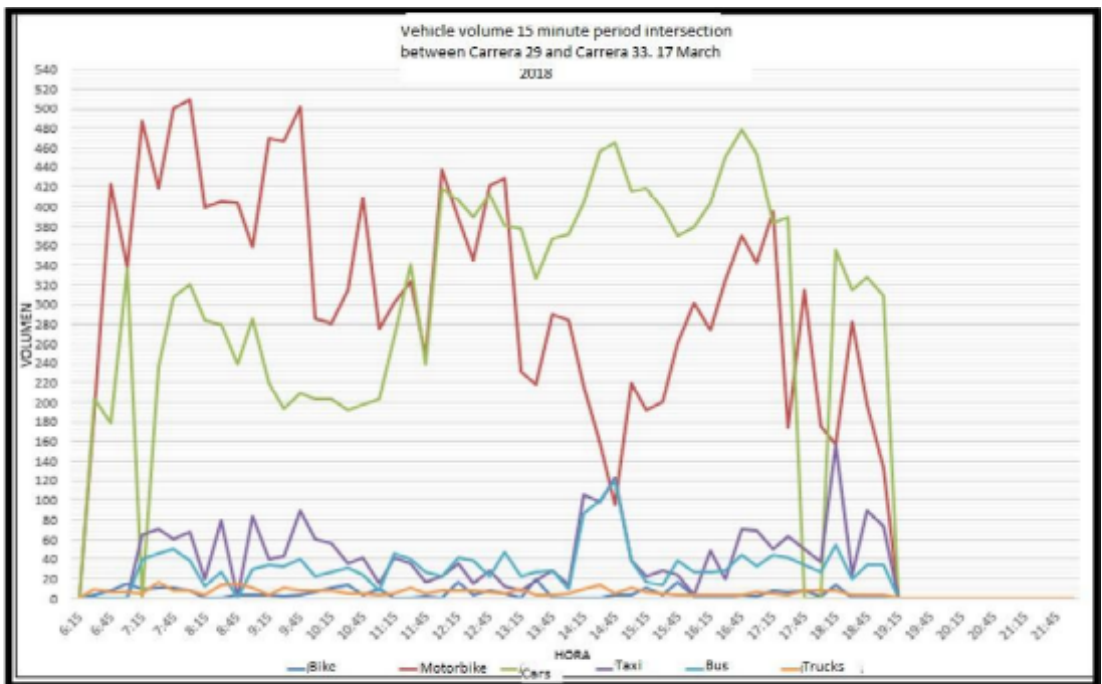
Figure 6: Vehicle volume acquired by a period of 15 min at the intersection 2 ( Carrera 33 with Carrera 29 ). Each color is associated with a specific means of transport ParadigmPlus (2021)